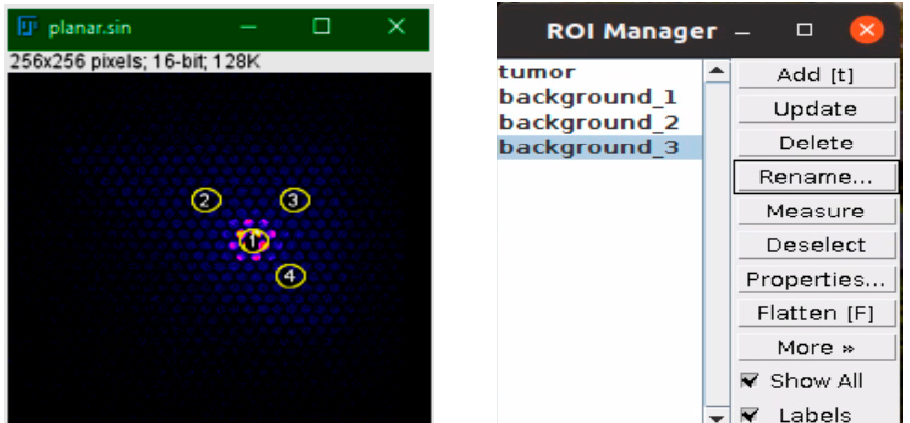
Figure 5. Example of ImageJ software used to assess the quality of liver and tumour planar images. Yellow circles (1, 2, 3, 4) represent the region of interest.